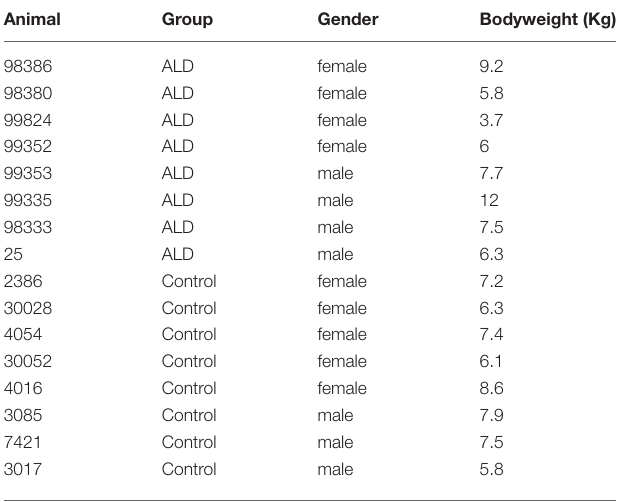
TABLE 2 | The serum plasma chemistry parameters in control rhesus monkeys and rhesus monkeys with alcohol induced liver steatosis. Variables